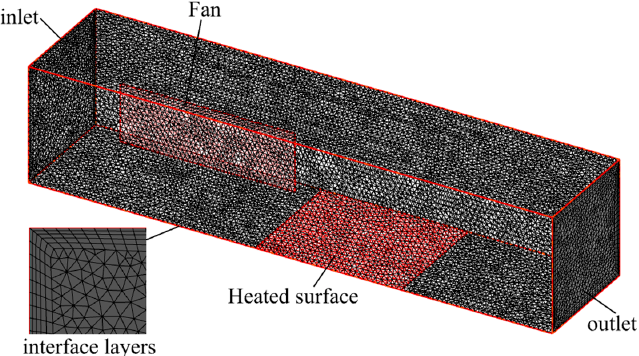
Figure 2. Computational domain grid diagram.